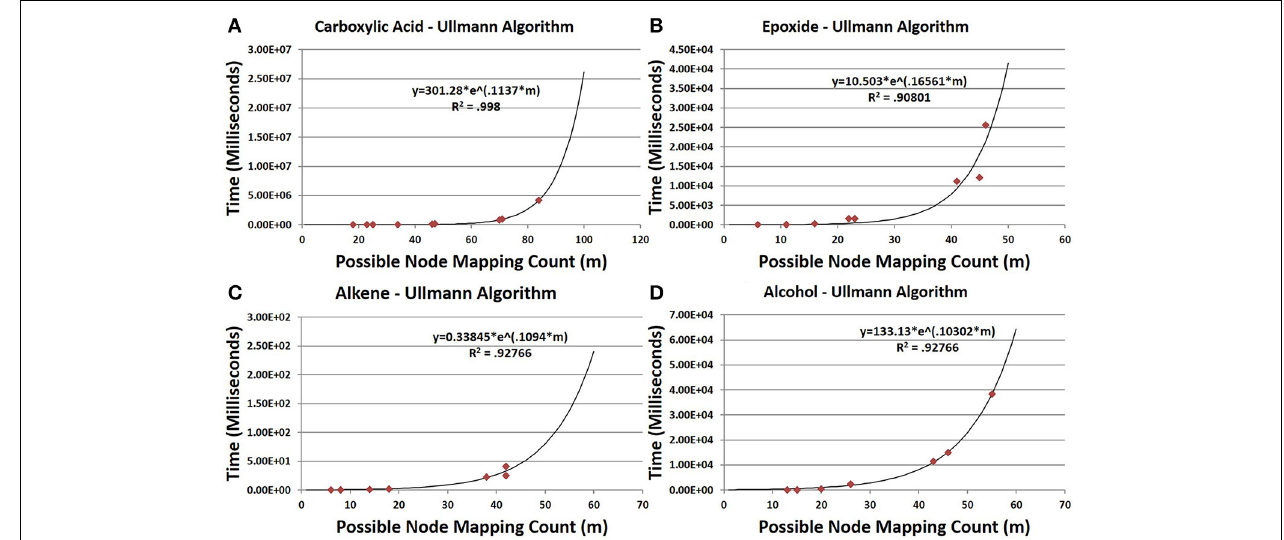
FIGURE 8 | Time trials for the Ullmann algorithm. In all cases, the time needed for the Ullmann algorithm to find all instances increases essentially exponentially with increasing m . Data were analyzed by non-linear regression to t = aexp(bt). (A,B,D) The time to search for carboxylic acids, epoxides and alcohols shows exponential growth with respect to m . (C) The time needed to search for alkenes, while also